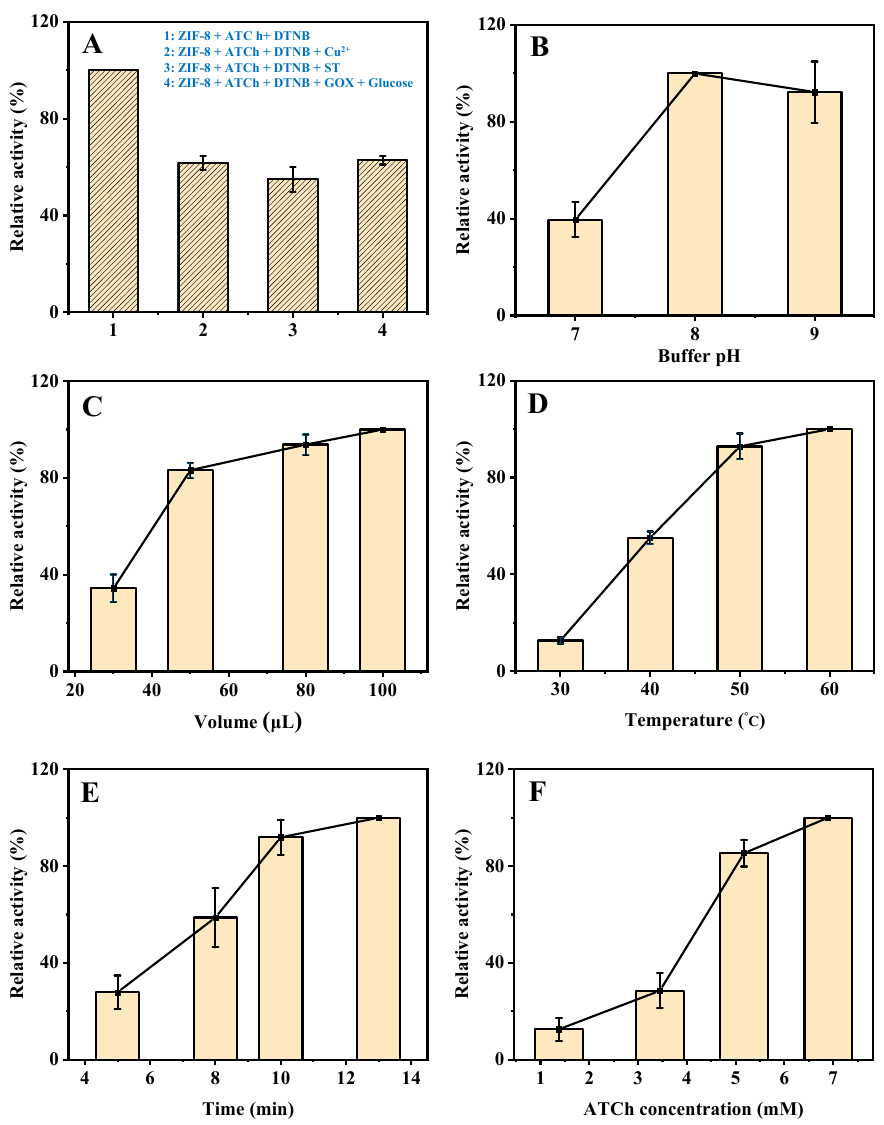
Figure 3. The UV absorption (405 nm) of ( A-1 ) ZIF-8 + ATCh + DTNB, ( A-2 ) ZIF-8 + ATCh + DTNB + Cu 2+ , ( A-3 ) ZIF-8 + ATCh + DTNB + ST, ( A-4 ) ZIF-8 + ATCh + DTNB + GOX + glucose. Effects of buffer pH ( B ), the volume of ZIF-8 ( C ), reaction temperature ( D ), reaction time ( E ), and the concentration of ATCh ( F ) on the AChE-like activity of ZIF-8. Buffer pH, 8.0 for ( A , C – F ); the volume of ZIF-8, 30 µL for B, 80 µL for ( A , D – F ); reaction temperature, 40 °C for ( B , C ), 50 °C for ( A , E , F ); reaction time, 8 min for ( B – D ), 10 min for ( A , F ); ATCh concentration, 1.51 mM for ( B – E ), 5.17 mM for ( A ); Other conditions: DTNB concentration, 1.38 mM; centrifugation time, 2 min; GOX initial concentration, 2 mg/mL; Cu 2+ , 21.55 µM; ST, 344.83 µM; glucose, 0.17 mM.